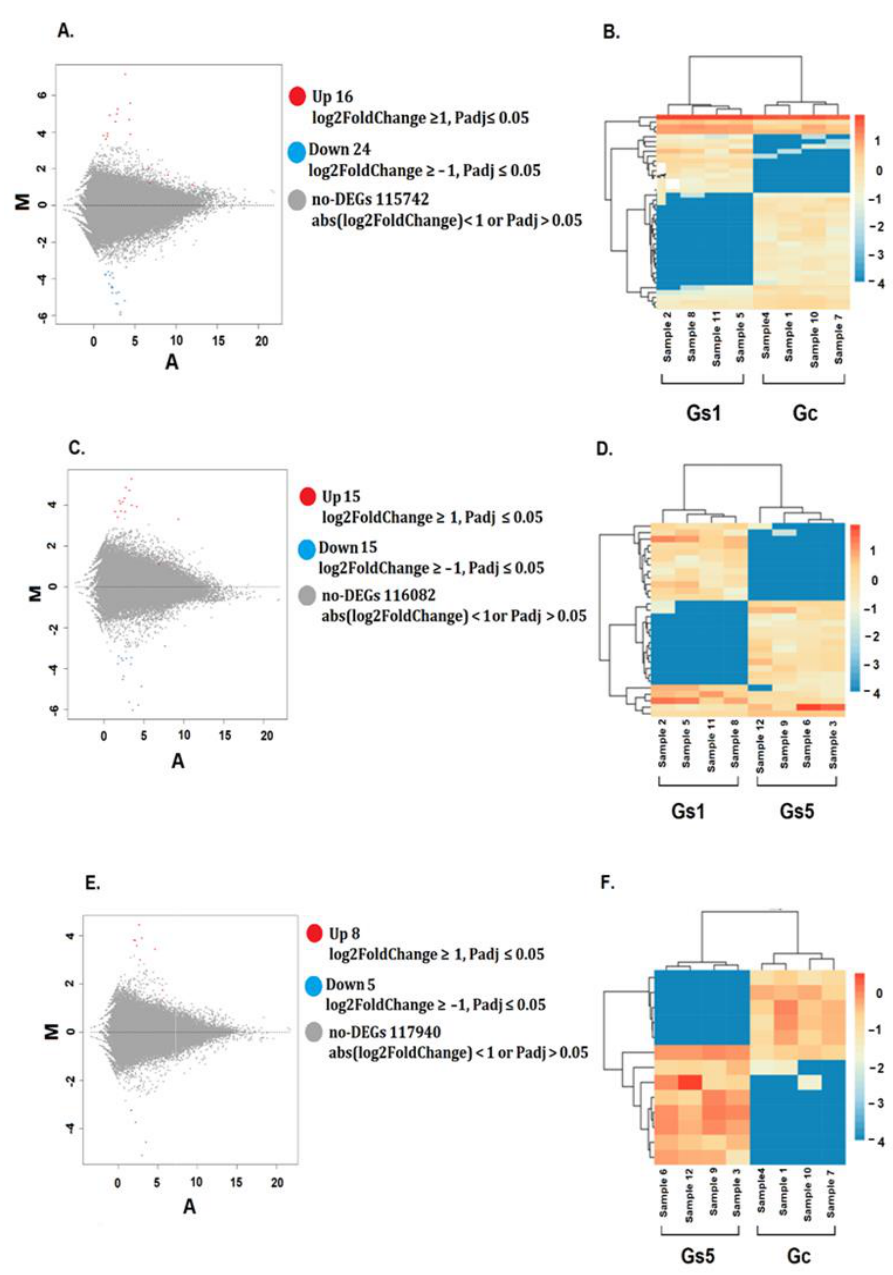
Figure 4. MA plots and heat maps representing the differentially expressed genes in the transcriptome of the loggerhead turtle, Caretta caretta . ( A , B ) Gc vs. Gs1, ( C , D ) Gs1 vs. Gs5, ( E , F ) Gc vs. Gs5.